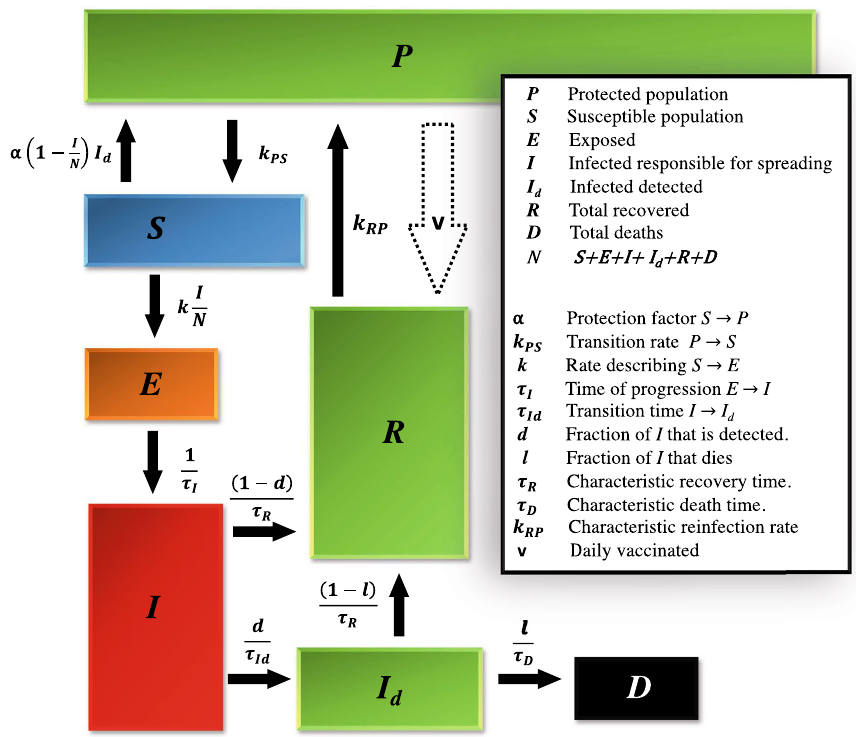
Figure 1. Compartment diagram of the alternative SEIRD(s) model, modified in order to accommodate protected individuals, P , to discriminate between detected, I d , and non-detected, I , infectious cases, and to include the process of vaccination. The flows between compartments are normalized and mathematically related to the model parameters, which are listed and briefly described in the box on the right hand